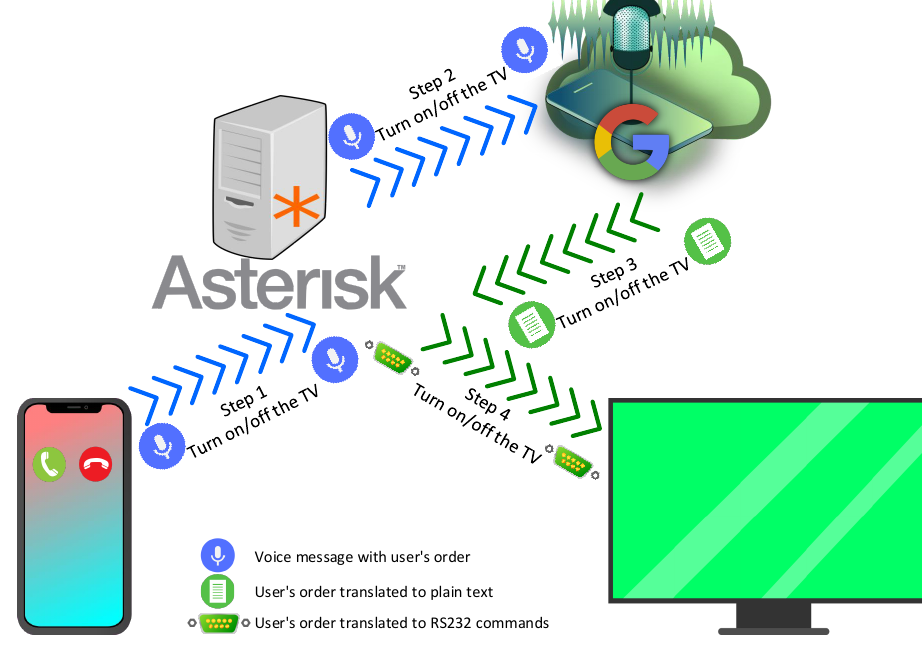
Figure 2. Architecture of the projects to manage a